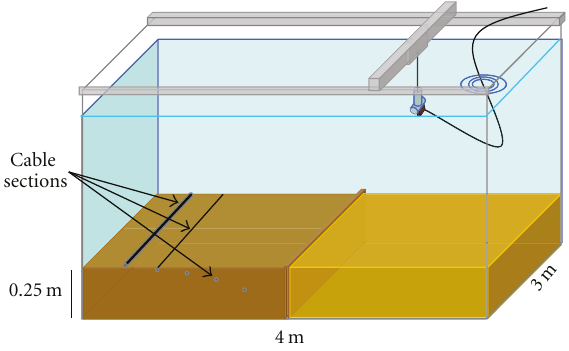
Figure 25: Test tank setup for buried cable